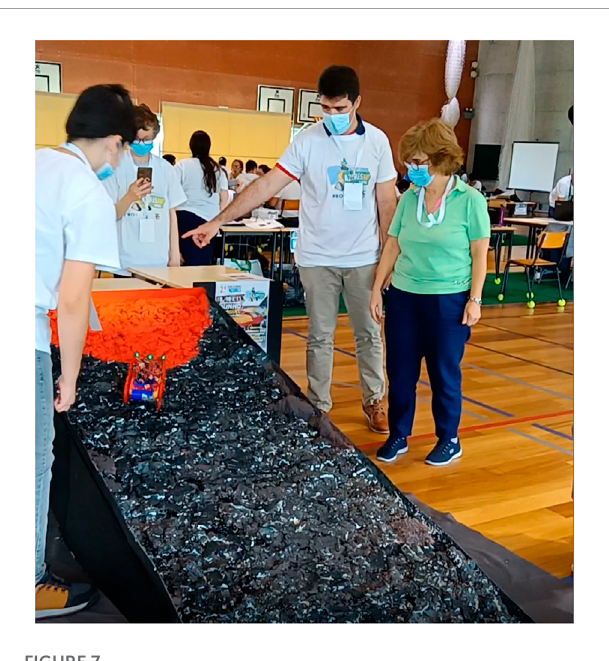
FIGURE 7 One of the teams testing the robot.